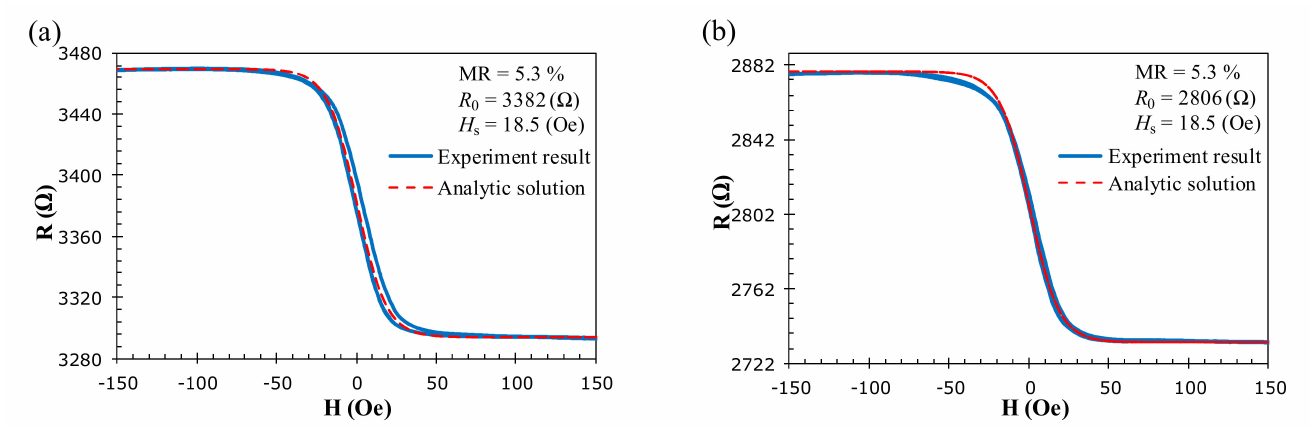
Figure 4. The MR curve for the spin-valve GMR elements: ( a ) the sensing element R 2 and ( b ) the reference element R 1